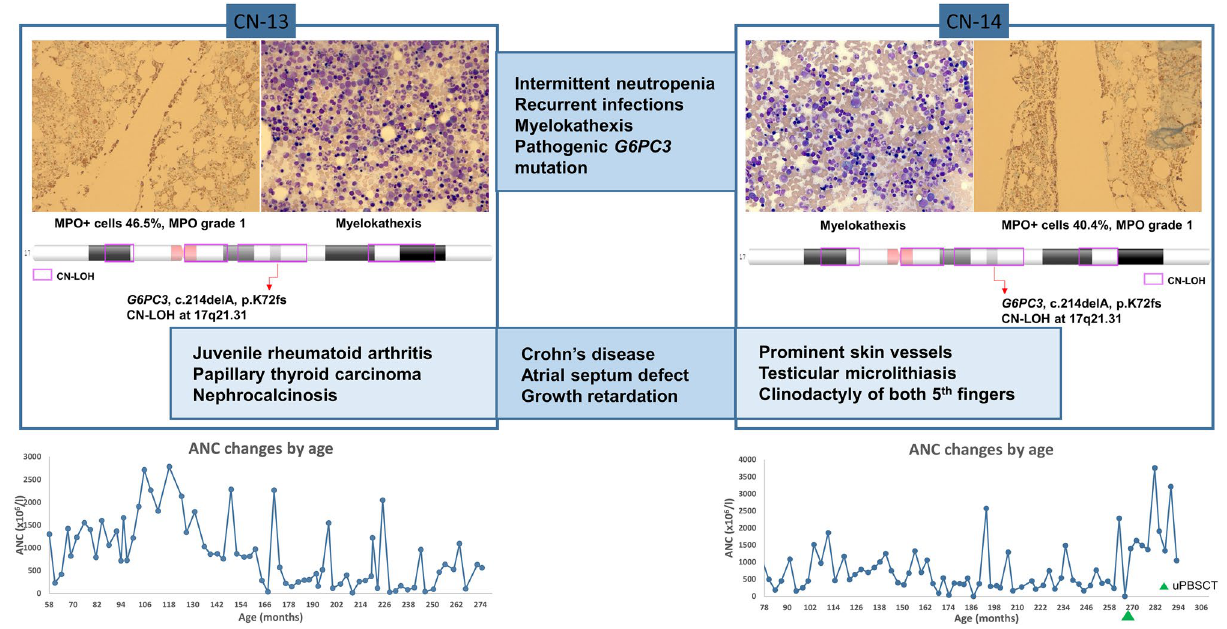
Figure 1. Overlapping clinical, histological and genetic characteristics of the two brothers with the G6PC3 mutation. Two brothers (P-13 and P-14) with the same pathogenic homozygous G6PC3 mutation (NM_138387.3:c.214delA, p.(K72fs)), which was caused by a copy-neutral loss of heterozygosity at 17q21.31, showed overlapping clinical manifestations and BM histologic features. Both of them presented